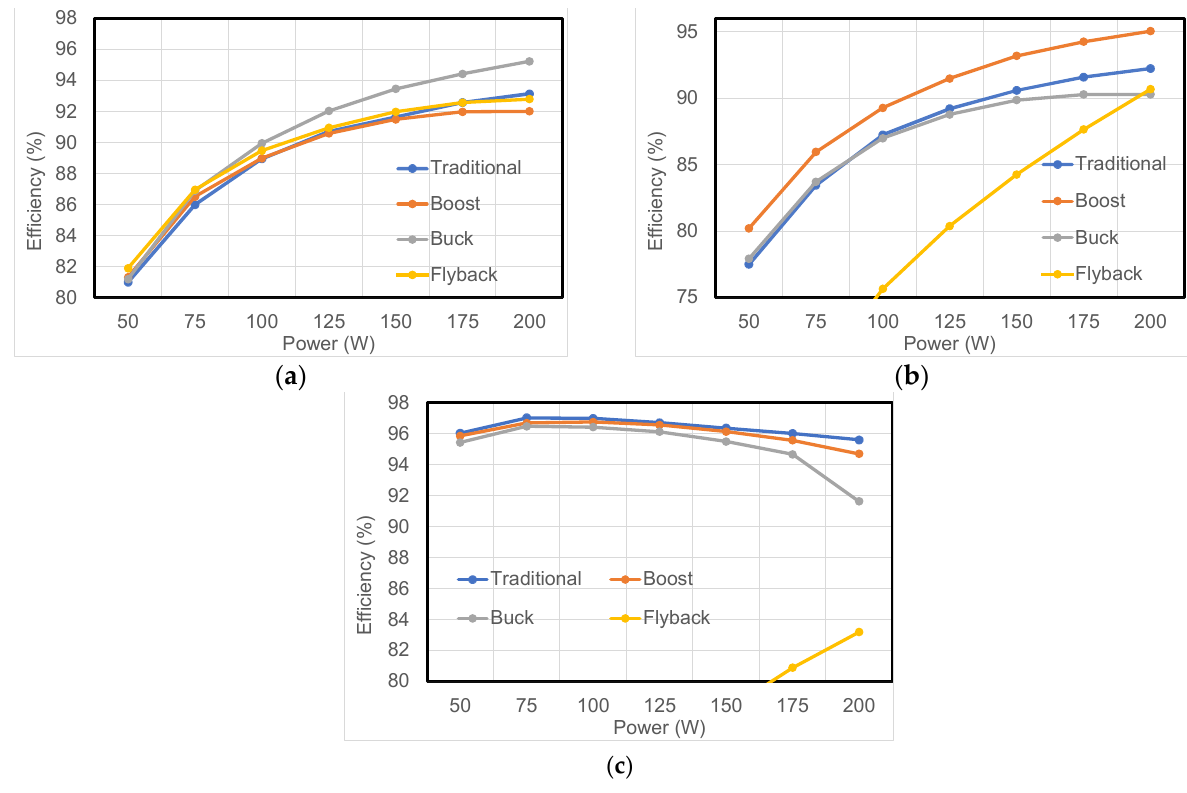
Figure 8. Experimental results. From top to bottom, input bridge output voltage, output bridge reflected output voltage, transformer inductance current: ( a ) traditional SPS modulation, for M = 1, ( b ) boost modulation, for M = 2, ( c ) buck modulation, for M = 0.5, and ( d ) flyback modulation, for M = 0.5.